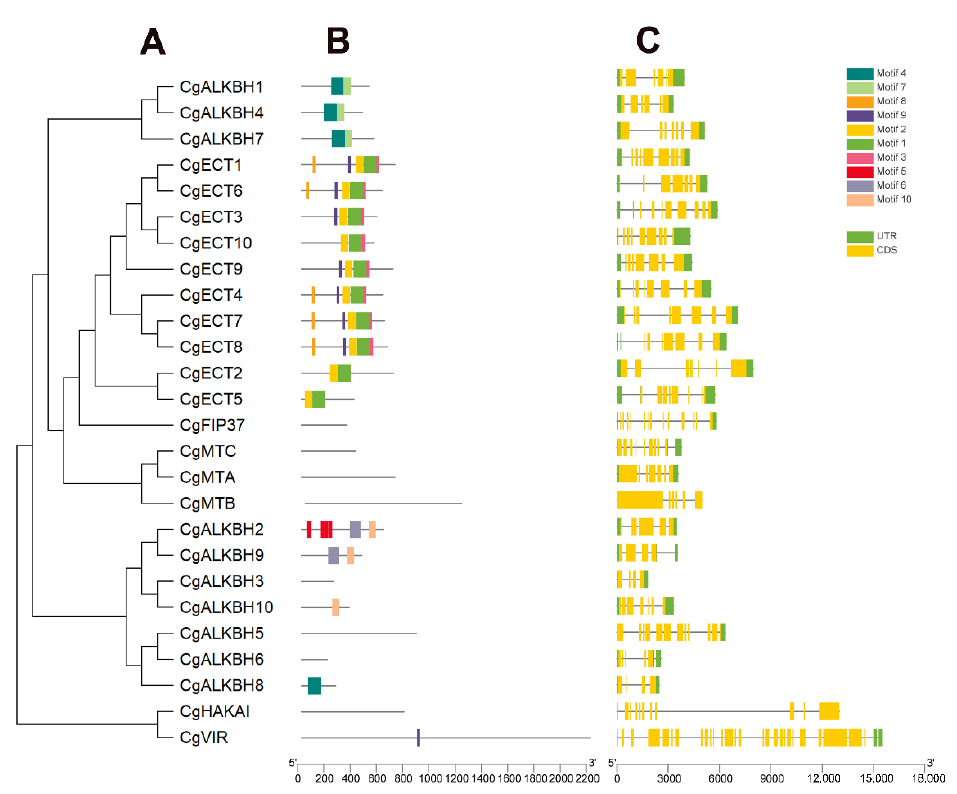
Figure 3. The gene structure analysis of m 6 A regulatory genes from C. grandis . ( A ) Phylogenetic relationship of m 6 A regulatory genes. ( B ) Conserved motifs analysis of m 6 A regulatory genes from C. grandis . All motifs were identified by the MEME database with the complete amino acid sequences of m 6 A regulatory genes from C. grandis . The detailed information for each motif is provided in Figure S1. ( C ) The exon and intron structures of m 6 A regulatory genes. Yellow represents exons.